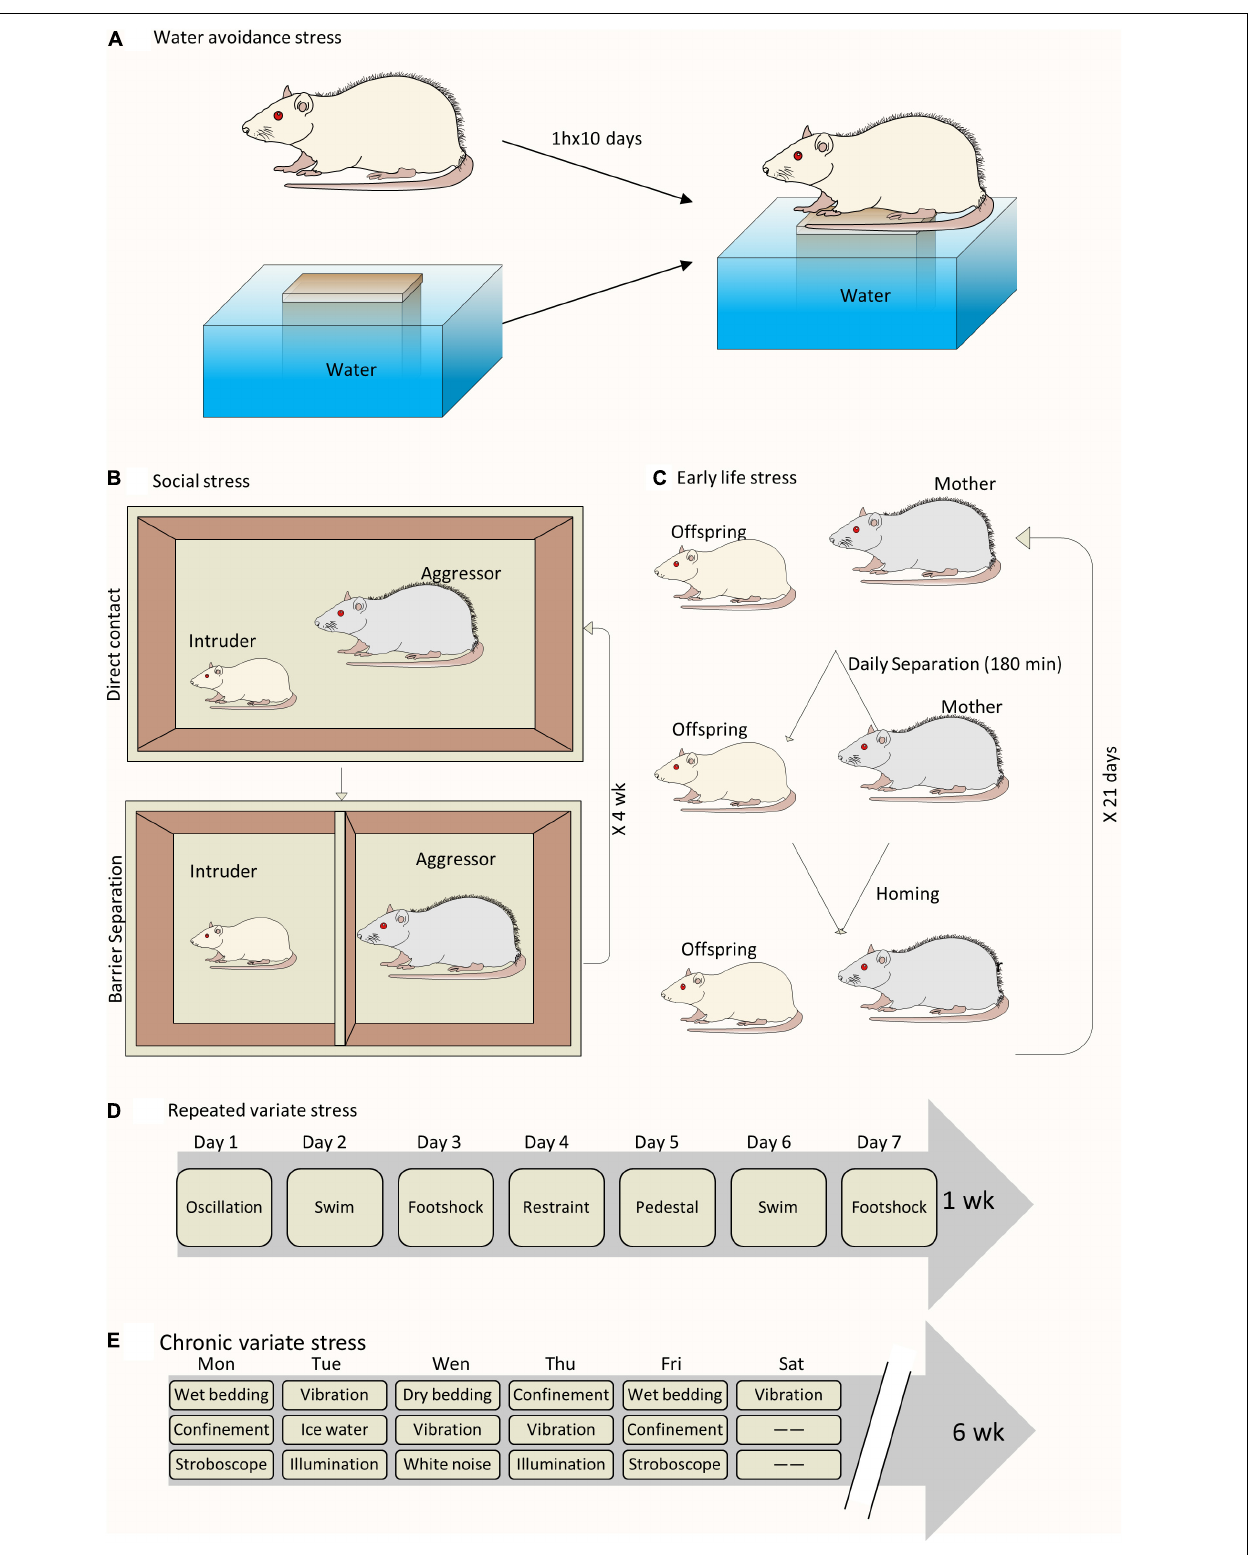
FIGURE 1 | Schematic drawing of different animal models to study chronic psychological stress-induced bladder dysfunction. (A) A sample of WAS model. (B) A sample of social stress model. (C) A sample of ELS model. (D) A sample of RVS model. (E) A sample of chronic variable stress model.